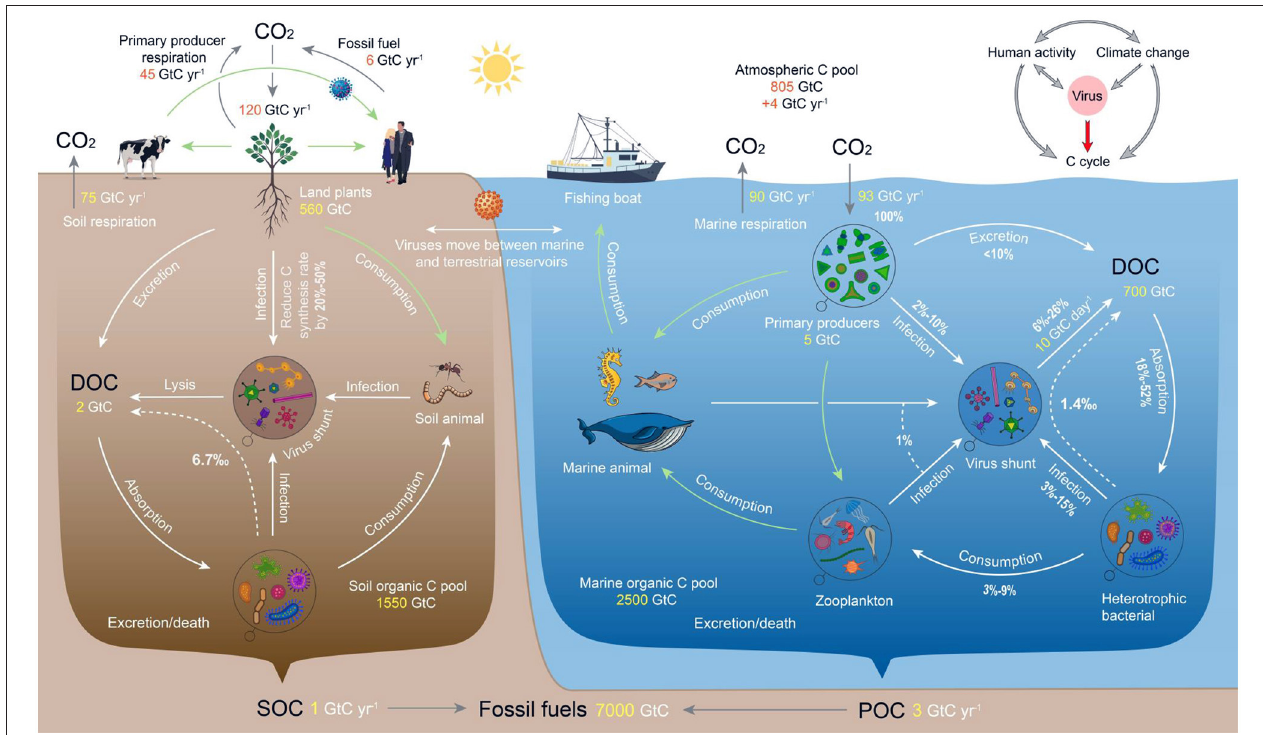
FIGURE 4 | Viruses are a “regulator” of the global ecosystem C cycle network. The gray arrows in the upper right corner of the diagram represent influence and the red arrow represents regulation. The arrows show the roles that viruses play in the traditional food web, the “microbial loop” and the C cycle network of ecosystems. Light green arrows represent the traditional food web, white arrows represent the microbial loop, white dotted arrows represent the contribution rate of C produced by viral lysing of bacteria to the ecosystem DOC pool, and gray arrows represent the intersystem migration C process. Additionally, C reserves and the C exchange volume are indicated in orange or yellow font. The schematic diagram of the freshwater ecosystem was similar to that of the marine ecosystem and is not shown separately. The “microbial loop” is an important supplement to the classic food chain, wherein dissolved organic matter (DOM) is ingested by heterotrophic “planktonic” bacteria during secondary production. These bacteria are then consumed by protozoa, copepods and other organisms, and eventually returned to the classical food chain. DOM includes three categories according to biological availability: labile DOM (LDOM; ∼ 26 Gt C), semi-labile DOM (SLDOM; ∼ 50 Gt C) and recalcitrant DOM (RDOM; ∼ 624 Gt C). All percentage values represent the flux of C fixed by primary producers (100%). See the Methods Section and Supplementary Table S4 for data sources.